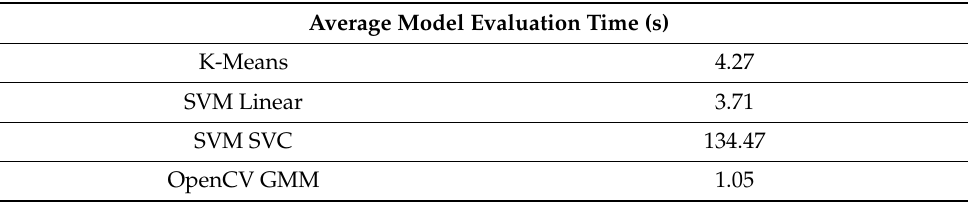
Table 3. Average time for a model to evaluate data. This average includes processing whole, 1st derivative, and 2nd derivative